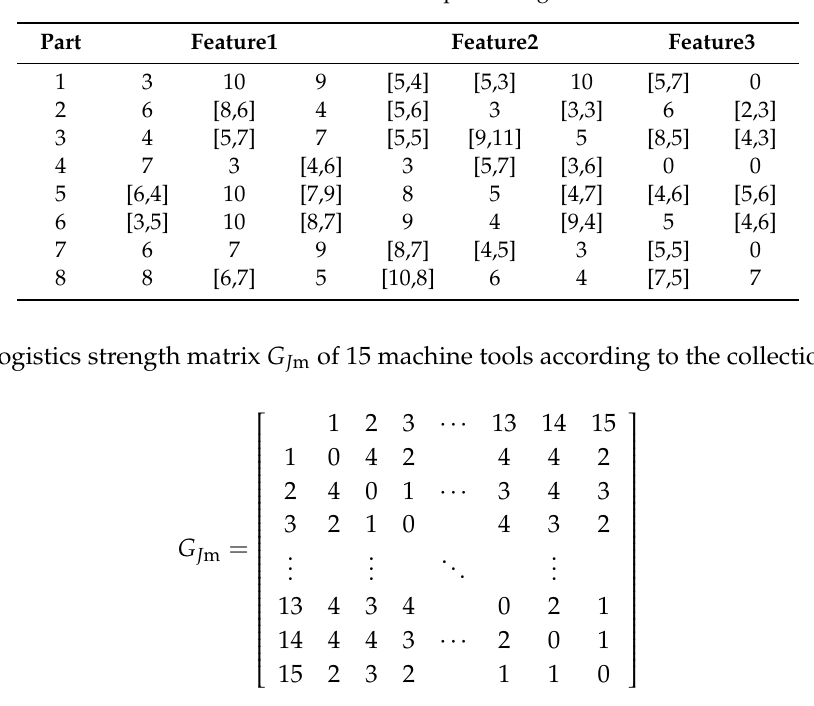
Table 2. Parts’ features processing